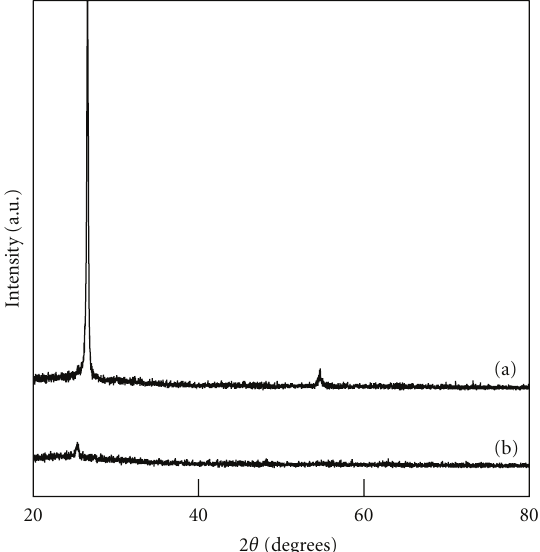
Figure 4: X-ray di ff raction patterns of prepared carbon pastes: amorphous nanocarbon (Printex L) and graphite (a); amorphous nanocarbon (Printex L) and active carbon